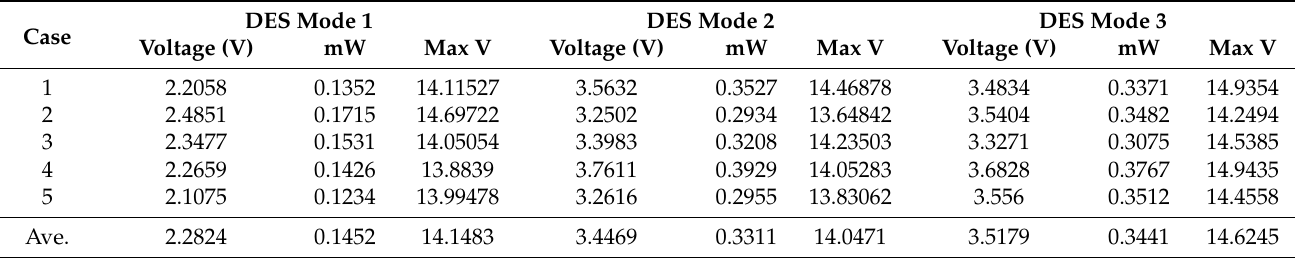
Figure 16. Schematic of SES and DES systems. Table 3. Experimental results of the voltage and power of the DES